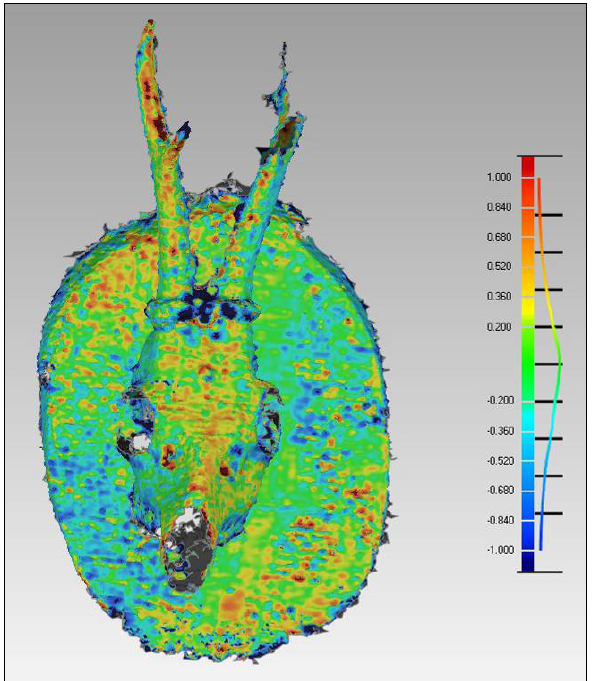
Figure 7. Deviations comparison of the DAVID model to the ARTEC model, threshold ± 1 mm